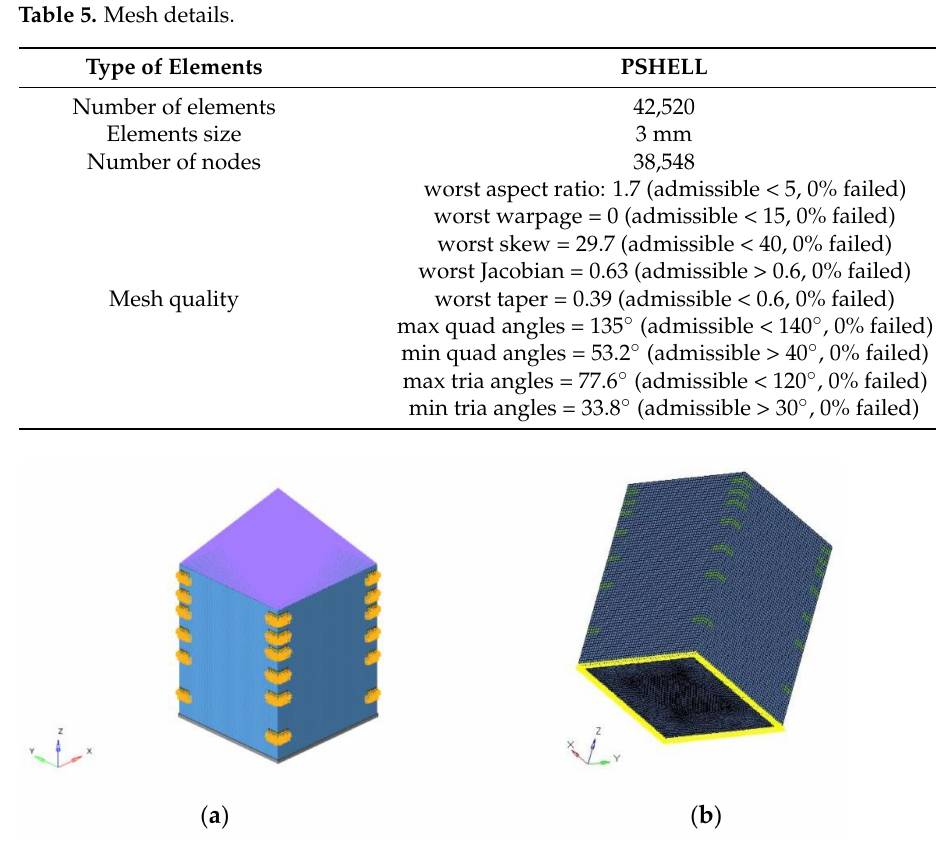
Figure 2. Picture of the bounding box and mesh used for the topology optimization ( a ) top view ( b ) bottom